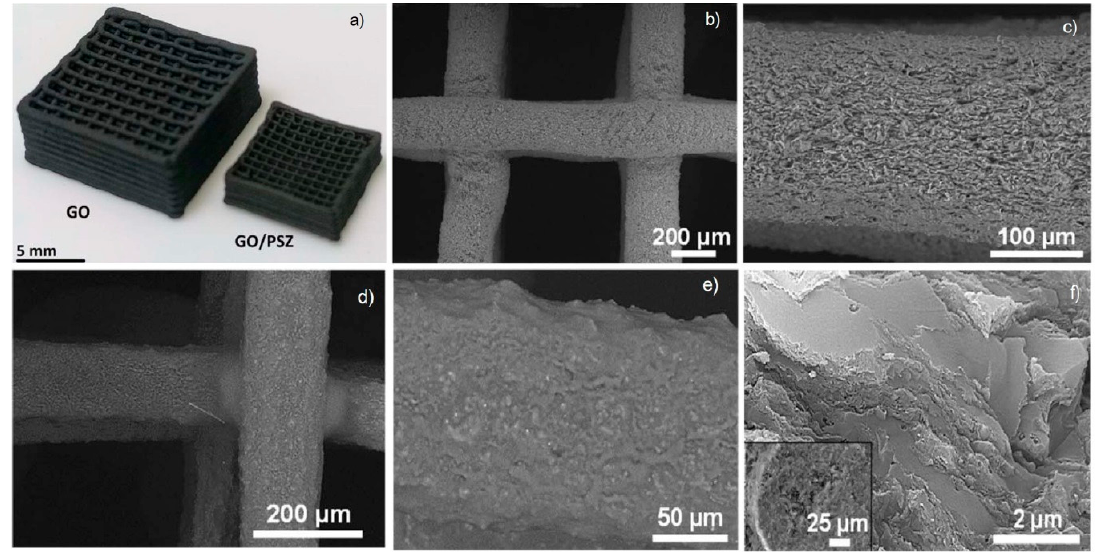
Figure 23. ( a ) 3D printed scaffolds of GO (as-printed) and the composite structure GO/PSZ pyrolyzed at 800 °C. SEM micrographs of a GO lattice after dying/lyophilization steps showing a top view ( b ) and the surface of an extruded filament ( c ). Analogous SEM images of a PSZ infiltrated GO lattice pyrolyzed at 800 °C in N 2 , ( d ) top view, ( e ) filament and ( f ) cross-section at different magnifications. Reproduced from [217], with permission from Elsevier, 2018.